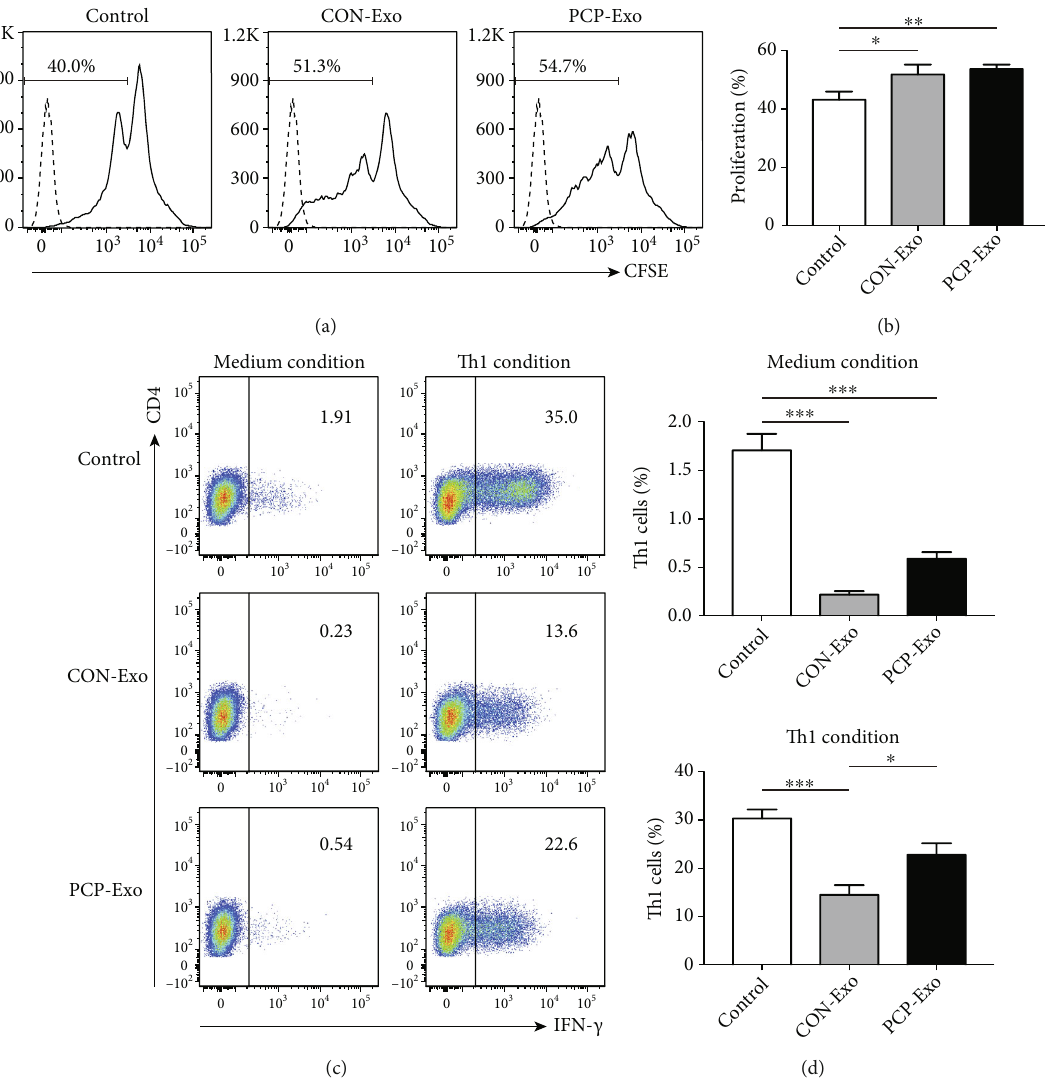
Figure 6: E ff ects of B cell-derived exosomes on CD4 + T cells. CD4 + T cells and naive CD4 + T cells were puri fi ed from the spleens of two wild-type mice and treated with CON and PCP B cell exosomes or left untreated (control). Proliferation and Th1 cell di ff erentiation rate were analyzed. (a) Representative fl ow cytometric histograms for CFSE of CD4 + T cells receiving di ff erent treatments. Dotted lines represent CFSE unlabeled control. (b) The comparison result of (a). (c) Representative fl ow cytometric dot plots showing the di ff erentiation of naive CD4 + T cells into Th1 subset and the corresponding comparison result (d). Comparisons were conducted by one-way ANOVA, followed by Bonferroni post hoc test ( n = 3 ). ∗ p < 0 : 05 ; ∗∗ p < 0 : 01 ; ∗∗∗ p < 0 : 001